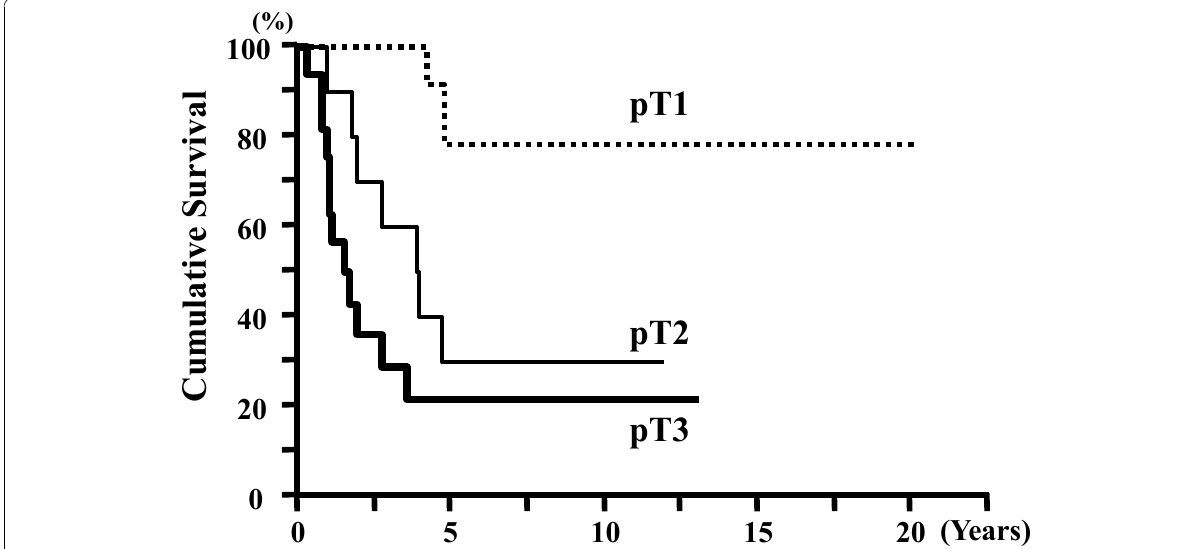
Figure 2 Cumulative survival of patients according to pathological tumor stage (pT) . Patients with early-stage tumors (pT1) showed significantly better survival than those with advanced-stage tumors (pT2 and pT3) (p < 0.001).